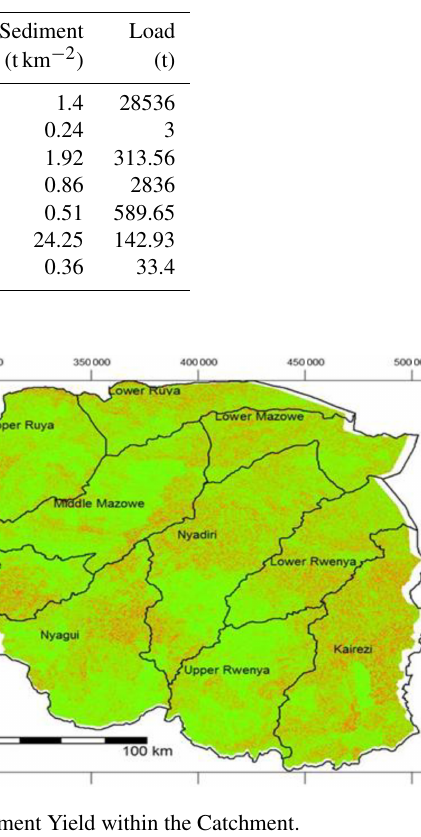
Table 3. Measured sediment Load from flow gauges for the period December 2014 to March 2015.